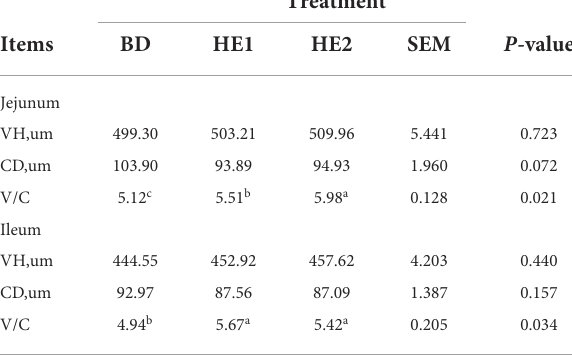
TABLE 5 Effect of HE on intestinal morphometry a .